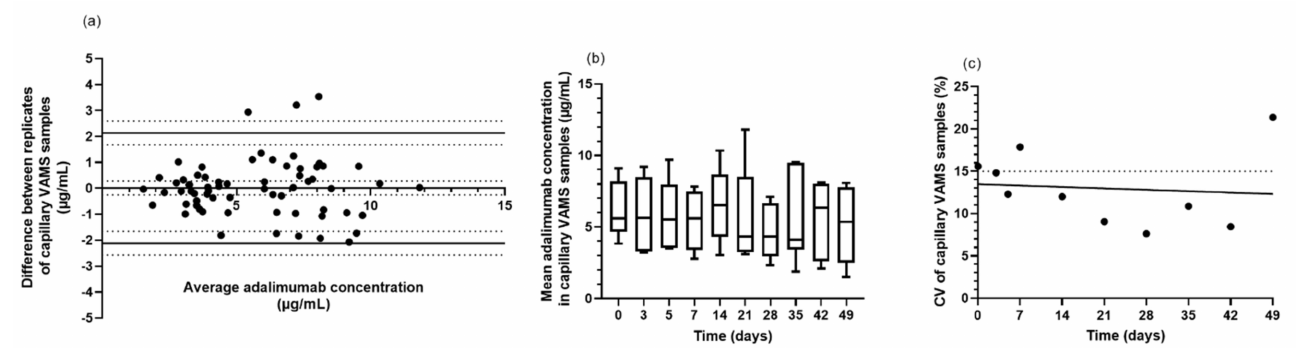
Figure 4. Patients’ performance on microsampling (capillary VAMS). Participants self-sampled VAMS twice in a row, these replicates being taken at 10 time points between day 0 and day 49. ADM was measured in capillary VAMS extracts with an in-house ELISA. ( a ) Bland–Altman plot for ADM quantification in capillary VAMS (n = 65). Mean bias and limits of agreement are represented by full lines, 95% CI by dotted lines. ( b ) Boxplots of mean ADM concentrations in capillary VAMS samples, taken at time points between day 0 and day 49. ( c ) CV (%) of replicates from capillary VAMS samples at the sampling time points between day 0 and day 49. The CV (%) threshold of 15% and the best fit curve (simple linear regression) are indicated by a dotted and full line, respectively.